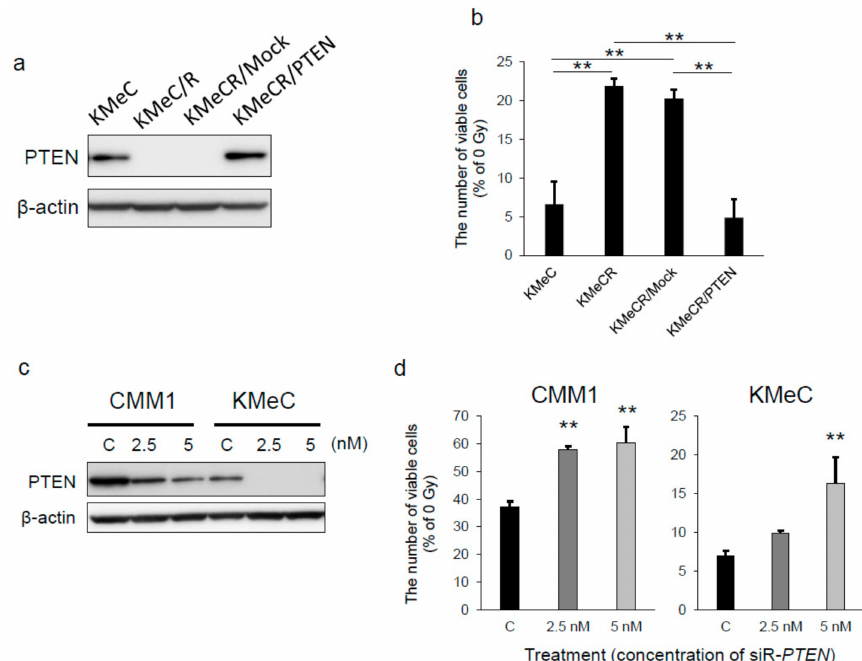
Figure 2. The e ff ects of overexpression or silencing of PTEN on the radiosensitivity. ( a ) Successful overexpression of PTEN in KMeC / R cells. ( b ) Cell count analysis of the cells indicated after 8 Gy of irradiation. The cell count was performed 72 h after the irradiation. The data are given as a % of the number of the cells without irradiation. ( c ) Evaluation of the e ff ects of silencing of PTEN by Western blotting analysis at 48 h after the transfection with siR-PTEN at indicated doses. ( d ) Cell count analysis of the cells transfected with siR-PTEN after 8 Gy of irradiation. The cell count was performed at 72 h after the irradiation. The data are shown as a % of the number of the cells without irradiation. ** p < 0.01, for di ff erences between the samples indicated by the horizontal line or between the cells transfected with the negative control and siR-PTEN. Data are expressed as the mean + SD ( n =